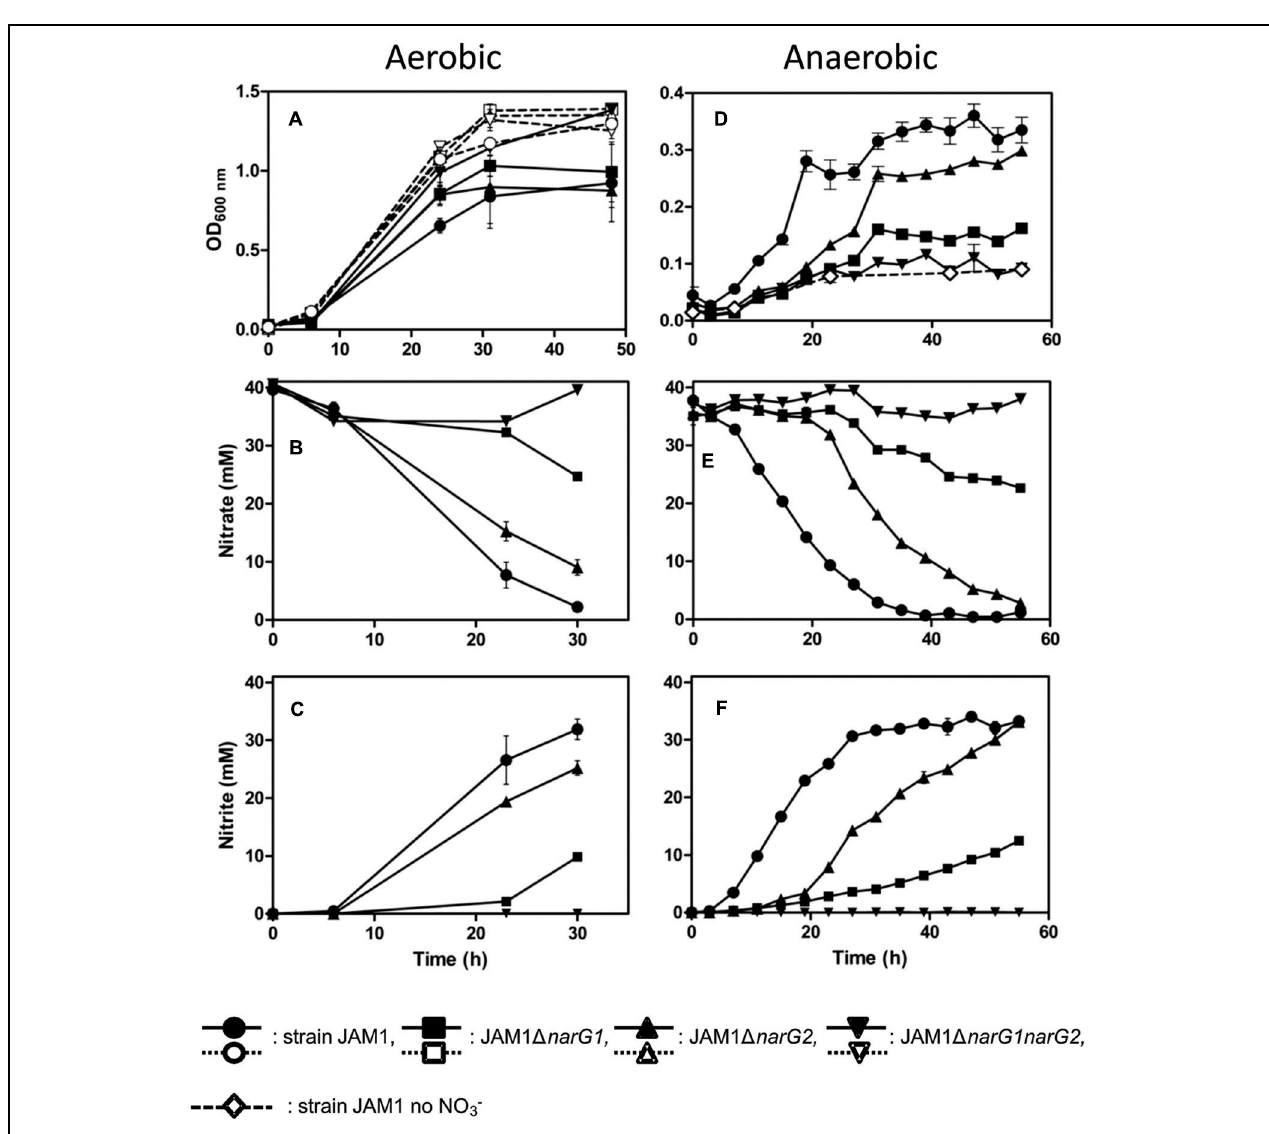
FIGURE 3 | Growth, nitrate reduction and nitrite production in cultures of strain JAM1 and the derivative narG mutants. Strain JAM1 and the narG mutants were cultured under aerobic conditions without nitrate ( A , dot lines), under aerobic conditions with nitrate ( A–C , solid lines) or under anaerobic conditions with nitrate (D–F) , solid lines). Control with strain JAM1 and no nitrate was also conducted under anaerobic conditions ( D , diamond with dash line). (A) and (D) : Growth. (B) and (E) : nitrate reduction. (C) and (F) : nitrite